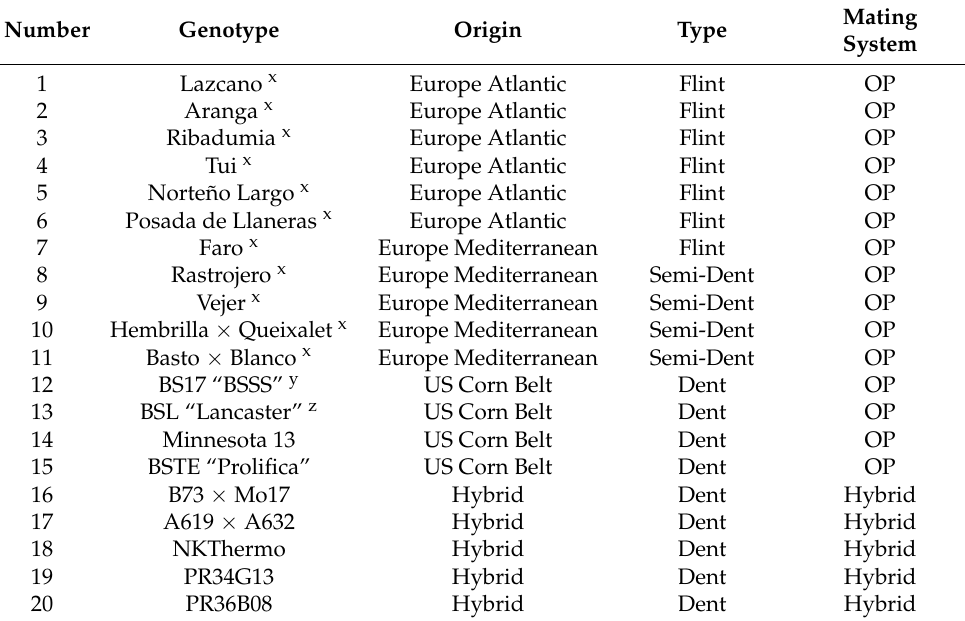
Table 1. Plant material evaluated in a randomized complete block design in Galicia, Spain, in 2010 and